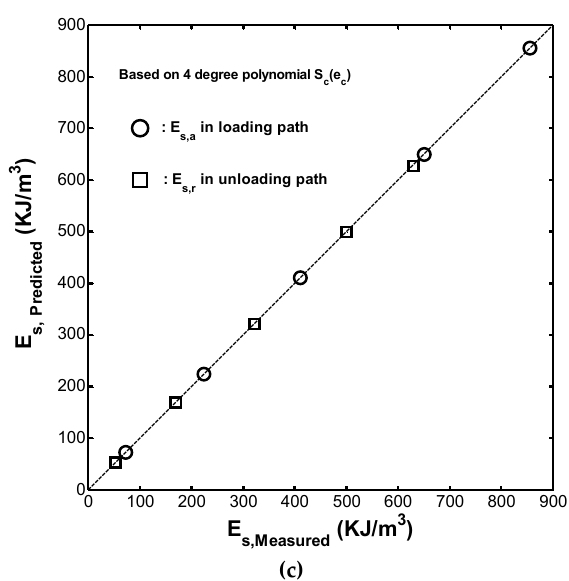
Figure 9. ( a ) Illustration of absorbed strain-energy-density E s , a and released strain-energy-density E s , r , ( b ) comparison of simulated and measured hysteresis loops, and ( c ) comparison of calculated and measured values of E s , a and E s , r for various strain ranges.